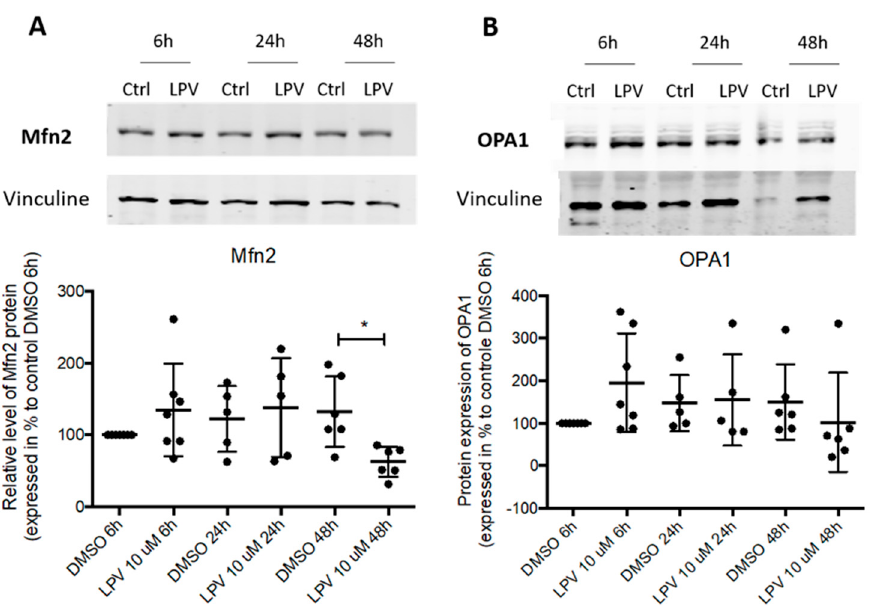
Figure 6. Impairment in mitochondrial dynamics during trophoblast differentiation under LPV exposition. Cytotrophoblast cells isolated from human term placentas were cultured for 15 h before to the incubation with LPV 10 µM or DMSO for 6 h, 24 h or 48 h. Mfn2 ( A ) or OPA1 ( B ) protein expression were evaluated by immunoblotting with anti-Mfn2 and anti-OPA1 antibodies. Vinculin protein expression determined with anti-vinculin antibody was used as loading control. Results are expressed as the mean +/ − SD of n = 7 independent experiments. * p < 0.05 vs. DMSO at the same incubation time, two-tailed paired no parametric student t -test.